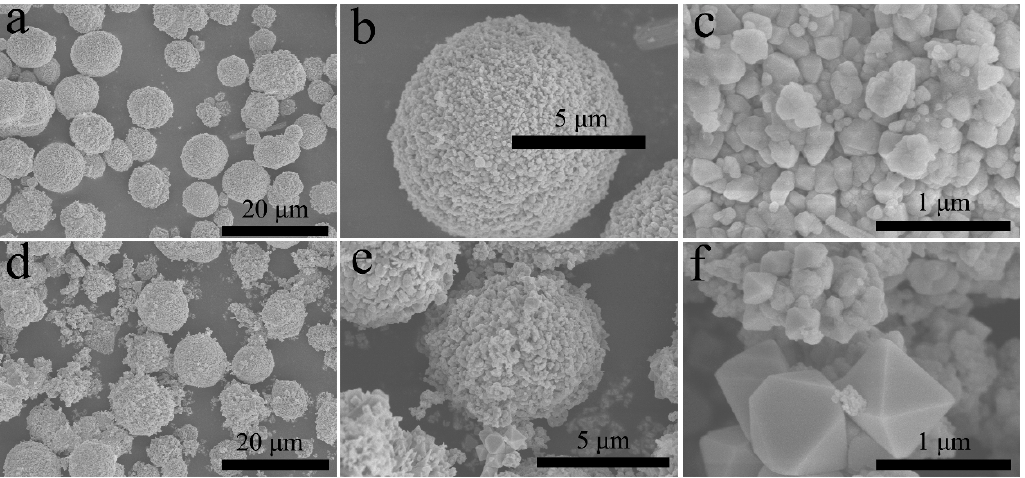
Figure 2. SEM pictures of as-synthesized photocatalysts: ( a – c ) 1.0 Ag 2 MoO 4 @InVO 4 , ( d – f ) 1.0 AgBr/Ag 2 MoO 4 @InVO 4 .